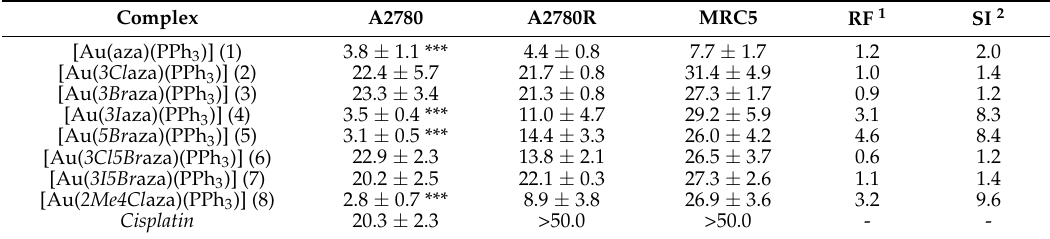
Table 3. The results of the in vitro cytotoxicity studies of gold(I) complexes 1 – 8 (and cisplatin for comparative purposes) against the human A2780 ovarian carcinoma, A2780R cisplatin -resistant ovarian carcinoma and MRC-5 normal fibroblast cell lines, performed with the 24 h exposure time. Data are expressed as half maximal inhibitory concentration (IC 50 ) ± standard deviation (SD) ( µ M). The significant differences between the IC 50 values for 1 – 8 and cisplatin are given as *** p <